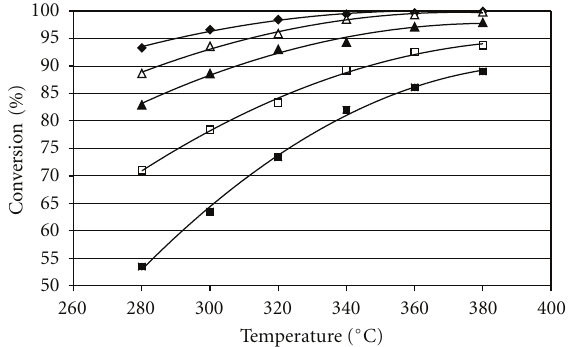
Figure 3: Conversion of triglycerides as a function of the temper- ature and the LHSV; where: -0.75h − 1 , Δ -1.0h − 1 , (cid:4) -3.0h − 1 of LHSV ( P = 80bar, H 2 /waste lard volume 2.0h − 1 and (cid:2) ratio = 600Nm 3 /m 3 ).